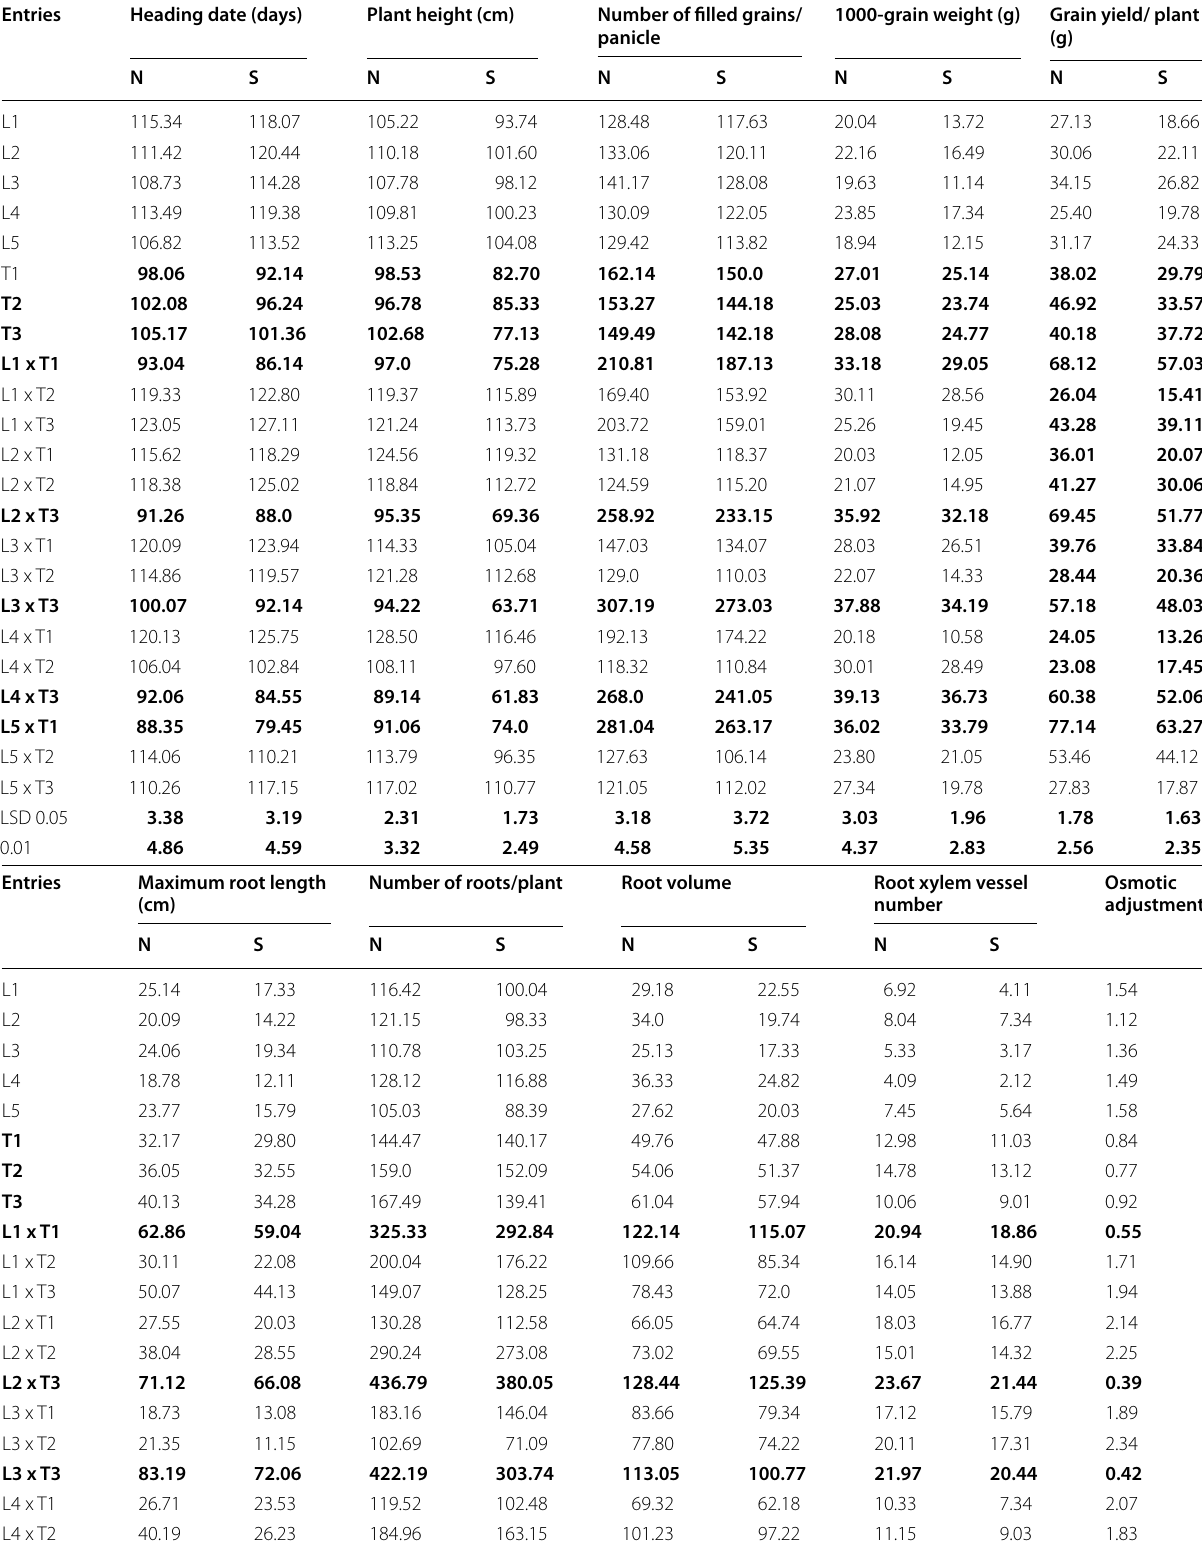
Table 3 Mean performance of all rice accessions for all studied traits for the two experiments of normal and drought stress conditions Entries Heading date